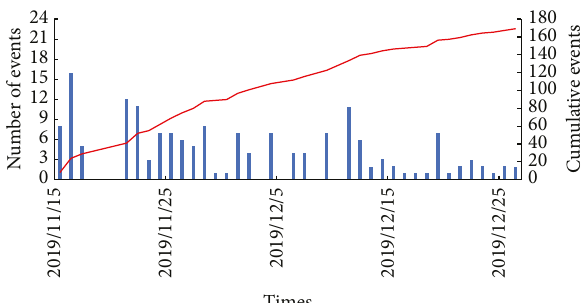
Figure 10: Time distribution of microseismic events in the tailrace tunnel.